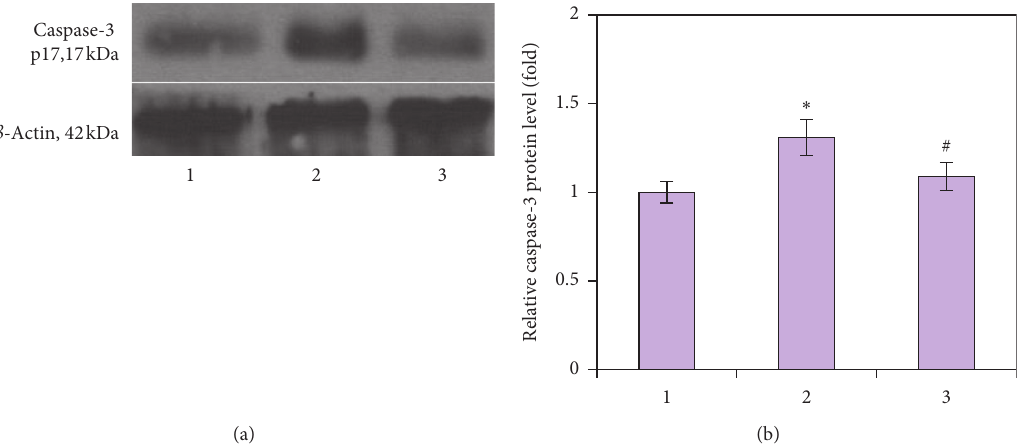
Figure 3: Effects of prednisolone and vitamin D 3 administration on the protein level of caspase-3 in bone tissue: (1) control; (2) prednisolone administration; (3) prednisolone and vitamin D 3 administration. Representative immunoblots (a) and quantification of caspase-3 level (b) are presented. Protein levels were normalized to β -actin. Results are shown as mean ± SEM of three independent experiments done in triplicate; ∗ p < 0 . 05 vs. control; # p < 0 . 05 vs. prednisolone